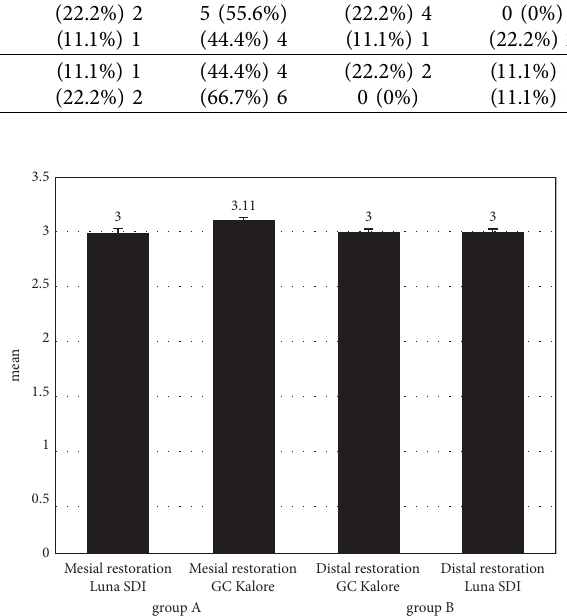
Table 2: Distribution of microleakage scores for two methacrylate-based composite (Luna SDI and GC Kalore). Group Cavity